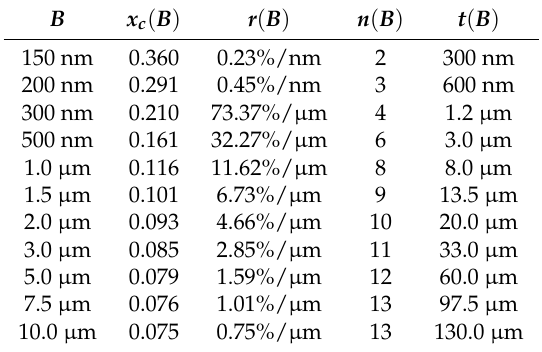
Table 1. Critical parameters and design of fully-coherent VHEs as function of B. The values of critical Ge content x c ( B ) , grading rate r ( B ) , number of layers n ( B ) to achieve x epi = 1 and corresponding total thickness t ( B ) under the assumption of h ∼ B are